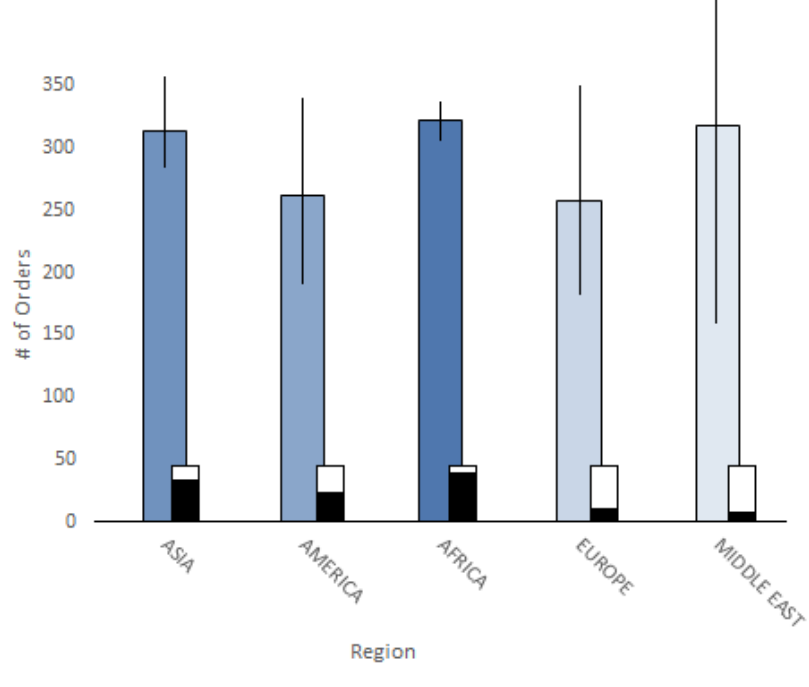
Figure 7. Demonstrating uncertainty encodings of relative error for bar charts using error bars and transparency. Weights for each group are encoded on the visualization with a black bar as a percentage from 0 to 100%. The higher the percentage, the heavier the weight (and therefore higher sampling